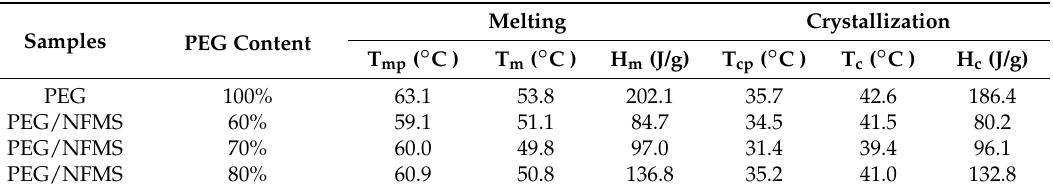
Table 1. Thermal characteristics of polyethylene glycol (PEG) and polyethylene glycol immobilized in nanoflower-like wrinkled mesoporous silica (PEG/NFMS).